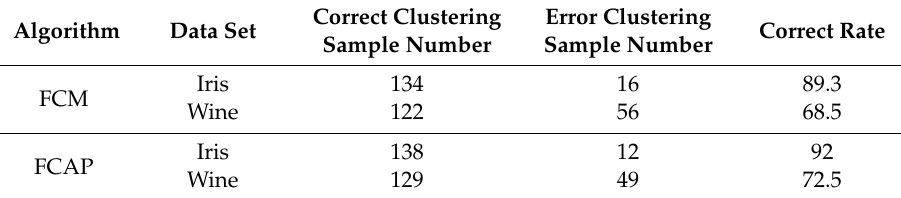
Table 3. Comparison of the clustering accuracy.